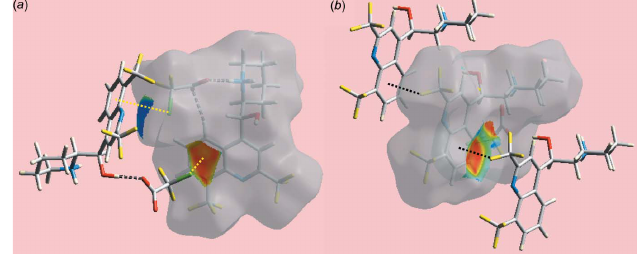
Figure 5 Two views of Hirshfeld surface of (I) mapped over the shape-index property highlighting ( a ) C—Cl (cid:2)(cid:2)(cid:2) (cid:2) and ( b ) C—F (cid:2)(cid:2)(cid:2) (cid:2) contacts by yellow and black dotted lines, respectively interatomic H (cid:2) (cid:2) (cid:2) H, F (cid:2) (cid:2) (cid:2) H/H (cid:2) (cid:2) (cid:2) F and F (cid:2) (cid:2) (cid:2) F contacts [Table 2; calculated in CrystalExplorer3.1 (Wolff et al. , 2012)]. On the Hirshfeld surfaces mapped over electrostatic potential in Fig. 4, the donors and acceptors of intermolecular hydrogen bonds are illustrated through the appearance of blue and red regions corresponding to positive and negative electrostatic potential, respectively. The presence of intermolecular side-on